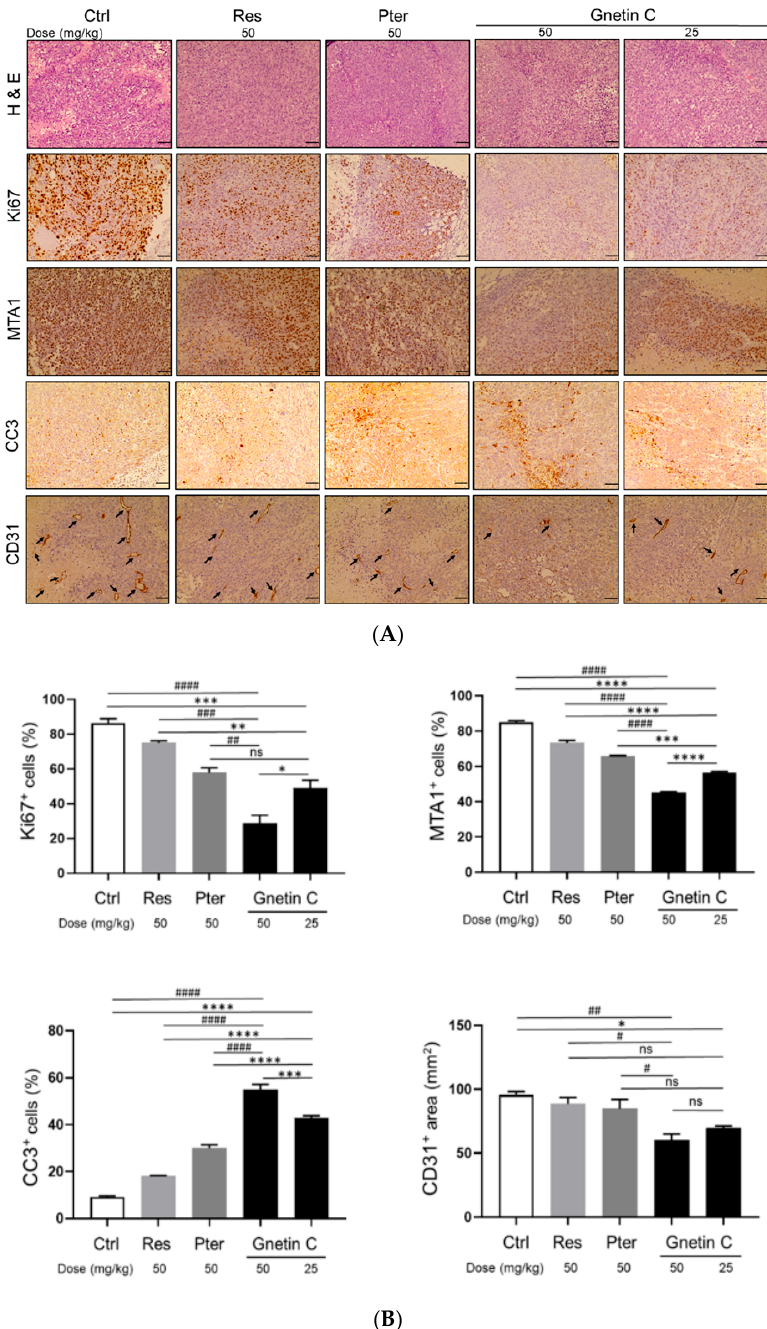
Figure 5. Gnetin C inhibits proliferation and angiogenesis, and induces apoptosis in PC3M-Luc s.c. xenografts. ( A ) Representative images of H&E ( top ), Ki67 ( second from top ), MTA1 ( third from top ) cleaved caspase 3 ( second from bottom ), and CD31 ( bottom )-stained sections of the tumor tissues from mice treated with compounds. H & E, MTA1, CC3 and CD31 are 20× images (scale bar, 50 µm); Ki67 is 40× image (scale bar, 20 µm). ( B ) Quantitative analysis of immunostainings showing drastic effect of Gnetin C treatment on markers of proliferation (Ki67), cell survival (MTA1), apoptosis (CC3), and angiogenesis (CD31) in tumor tissues. Arrows indicate microvessels on the bottom panels. Values are means ± SEM of cells counted in five separate fields per sample ( n = 7/group), and the average count is expressed as a percent. ns non-significant; * p < 0.05; ** p < 0.01; *** p < 0.001; **** p < 0.0001 (significance vs. Gnetin 25); # p < 0.01; ## p < 0.01; ### p < 0.001; #### p < 0.0001 (significance vs. Gnetin 50) (two-way